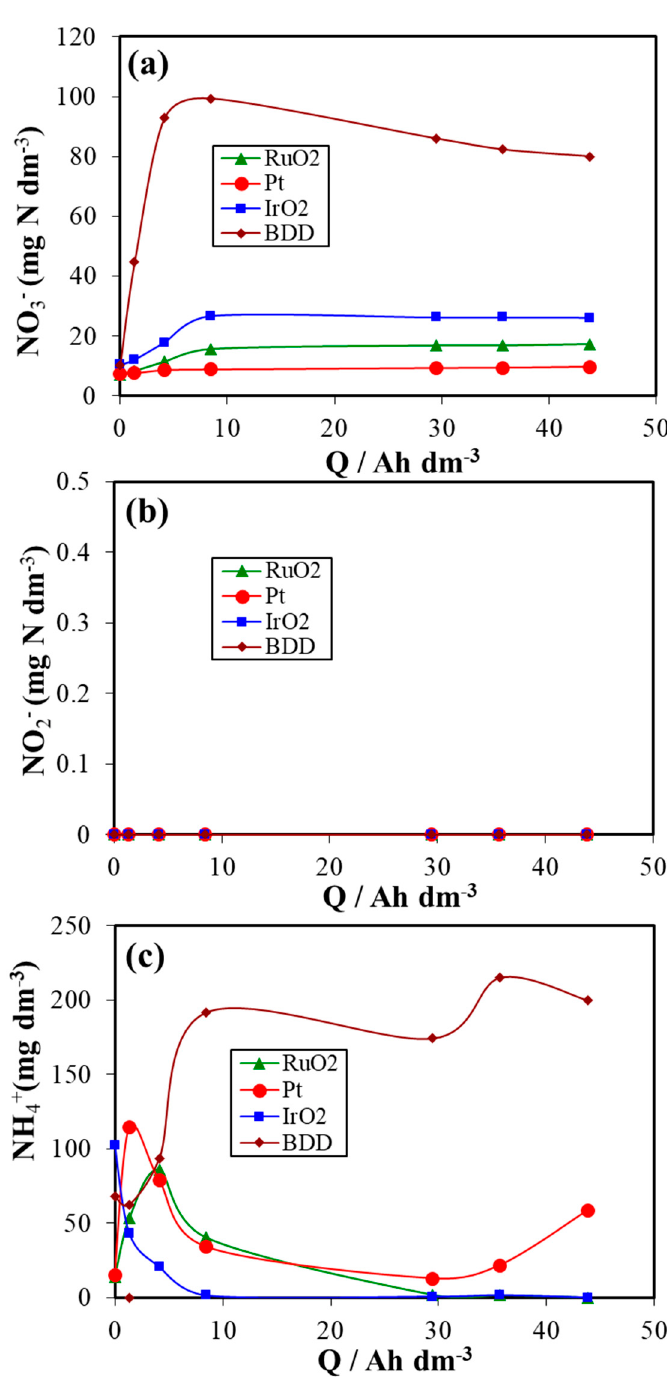
Figure 6. Speciation of nitrogen species during the electrochemical treatment of urine wastewaters with di ff erent anode materials. ( a ) Nitrates, ( b ) Nitrites, and ( c ) Ammonium. In this treatment, the initial concentration of nitrogen in urine wastewaters is about 489 mg dm − 3 and this nitrogen is mostly associated with urea in raw synthetic urine ( > 95%) being the rest free ammonium ion (6 mg dm − 3 ) and organic nitrogen (associated with creatinine and uric acid). However, there is an important di ff erences observed between the BDD anode and the other three anodes (IrO 2 , RuO 2 and Pt) in terms of the concentration of nitrate and ammonium. It should be noted that the − 3 − 3 − 3 − 3 concentration of nitrate attains about 100 mgN dm , 27 mgN dm , 16 mgN dm and 9 mgN dm and the concentration of ammonium reaches about 168 mgN / L, 34 mgN / L, 67 mgN / L and 89 mgN /